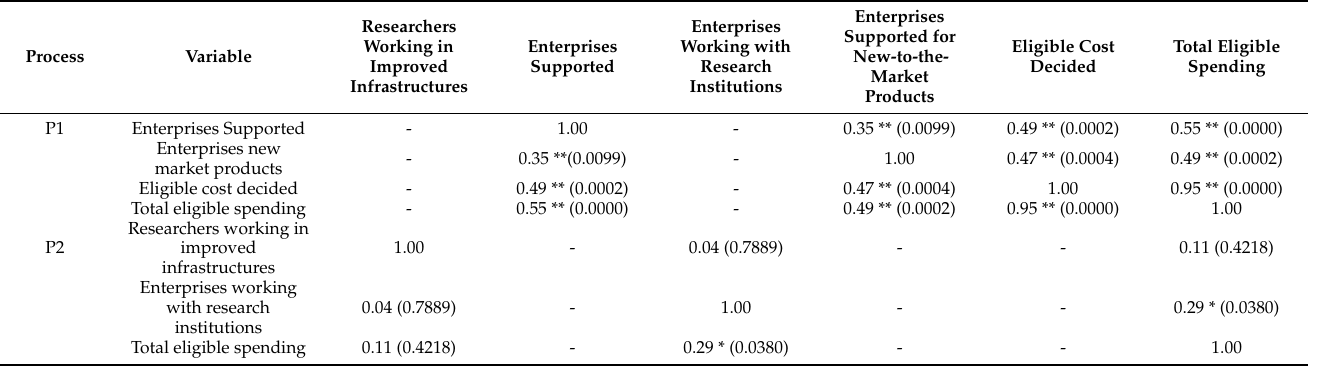
Table 5. Correlation